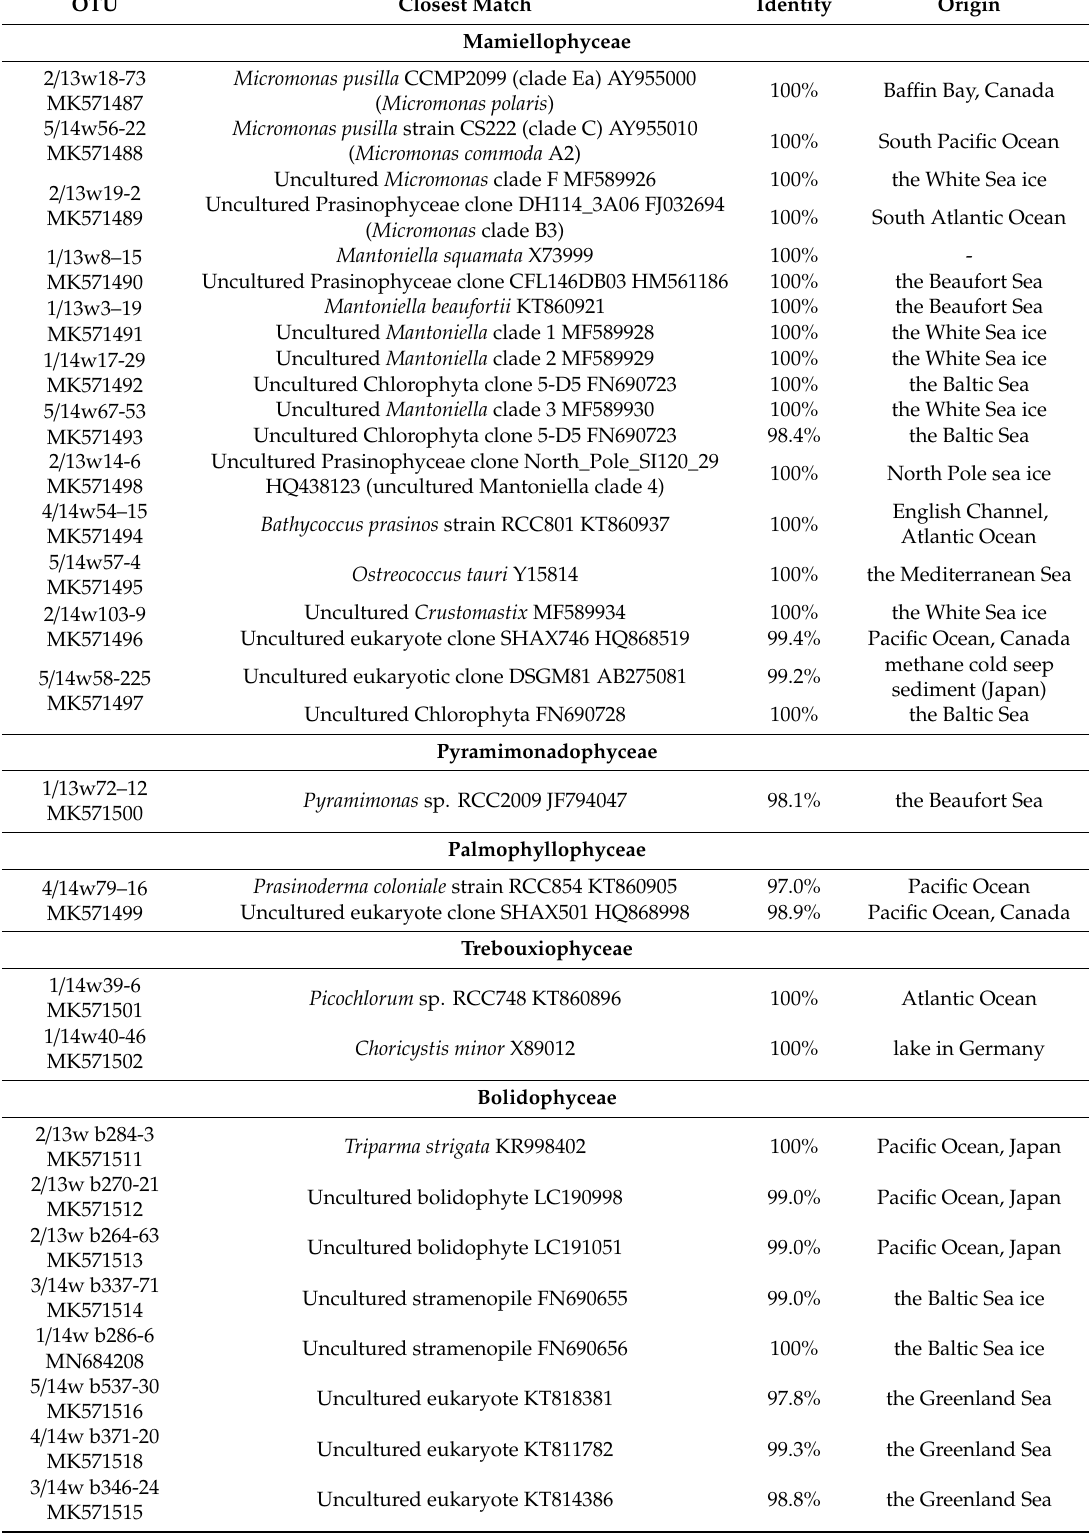
Table 5. The most abundant PPEs OTUs recovered in the under-ice water of Kandalaksha Bay, the White Sea in March 2013 and 2014 (clustering at 97% similarity threshold). The number of reads of each OTU is indicated in